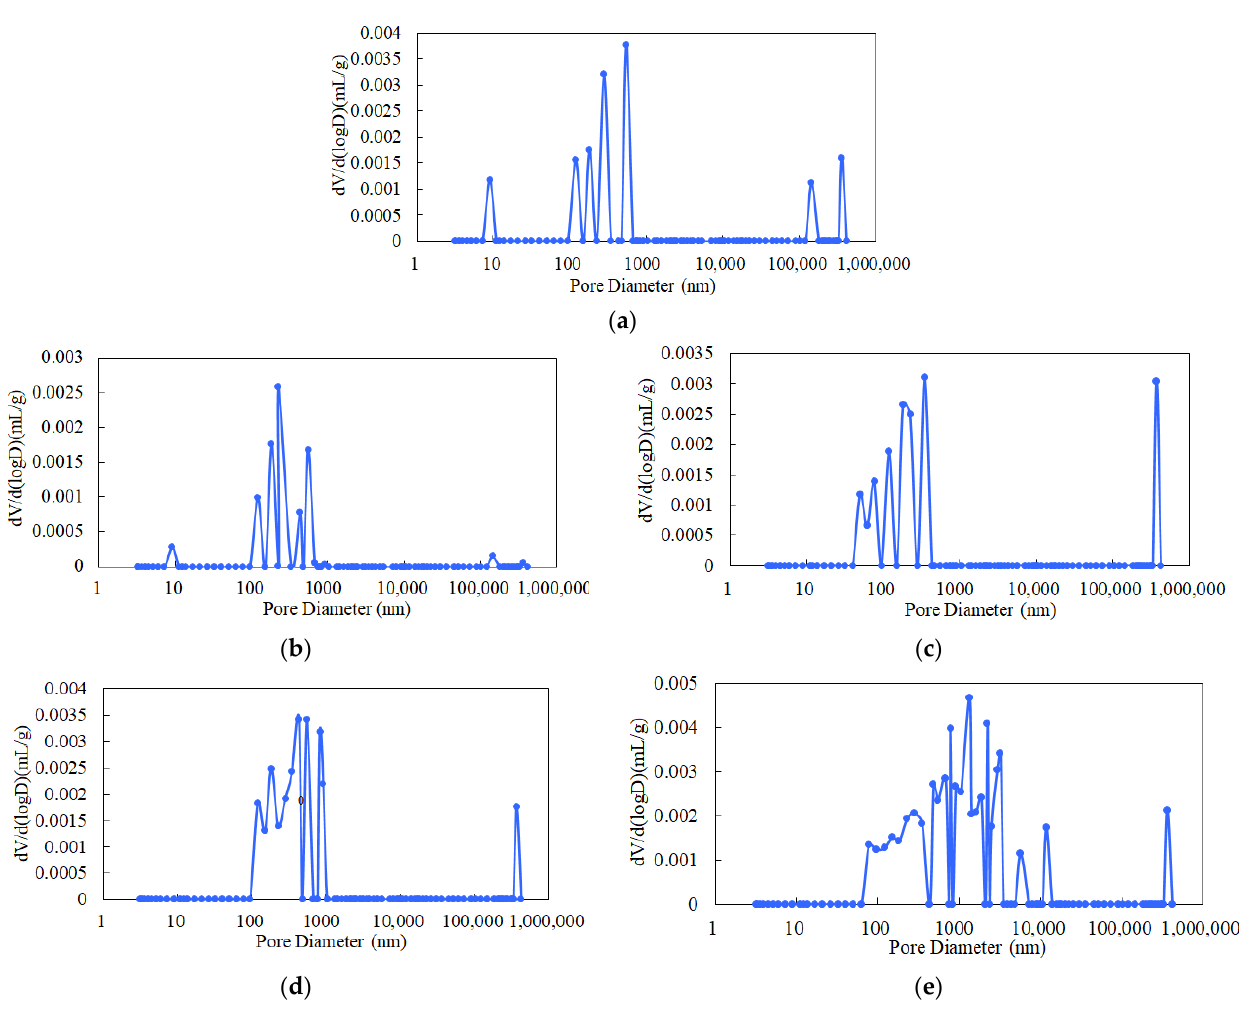
Figure 10. Pore size distribution of granite at different temperatures: ( a ) 25 °C, ( b ) 100 °C, ( c ) 200 °C, ( d ) 300 °C, ( e ) 400 °C.